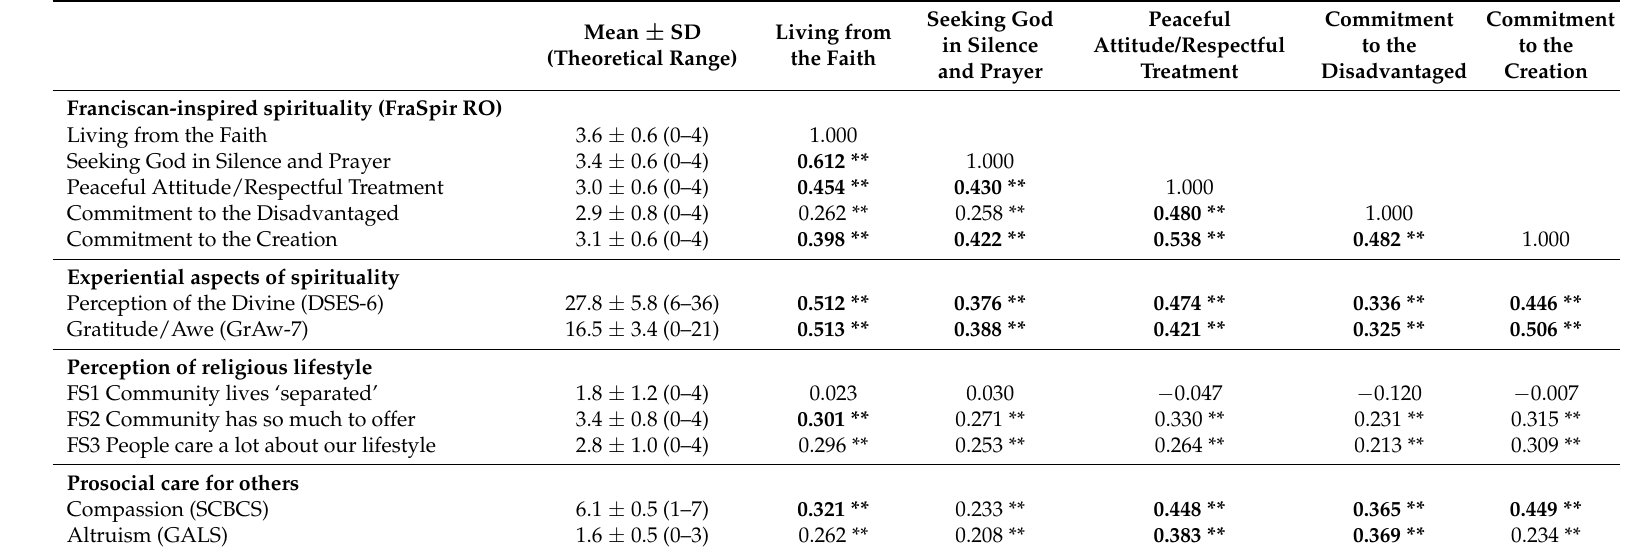
Table 4. Correlation between FraSpir RO attitudes and behaviors and external